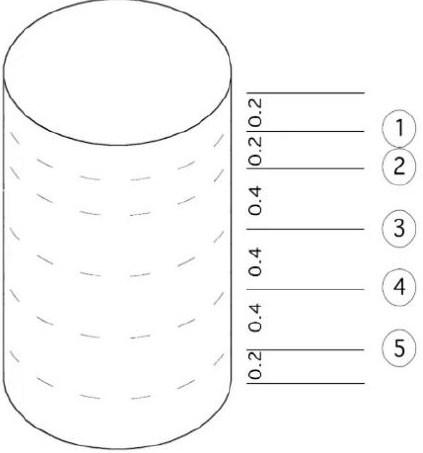
Figure 9. Arrangement of testing points in the air duct model (side view).